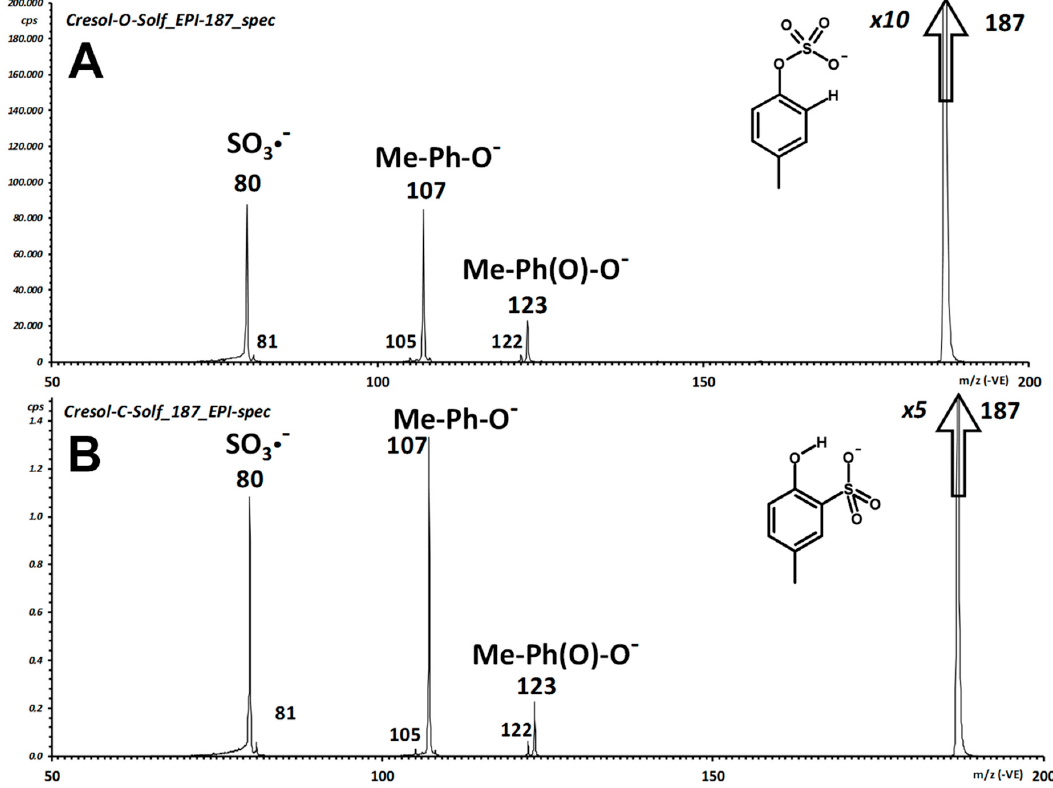
Figure 5. Integrated fragment spectrum of p CS ( 1 ; A ) and 2-hydroxy-4-methyl-phenylsulfonic acid ( 2 ; B ).